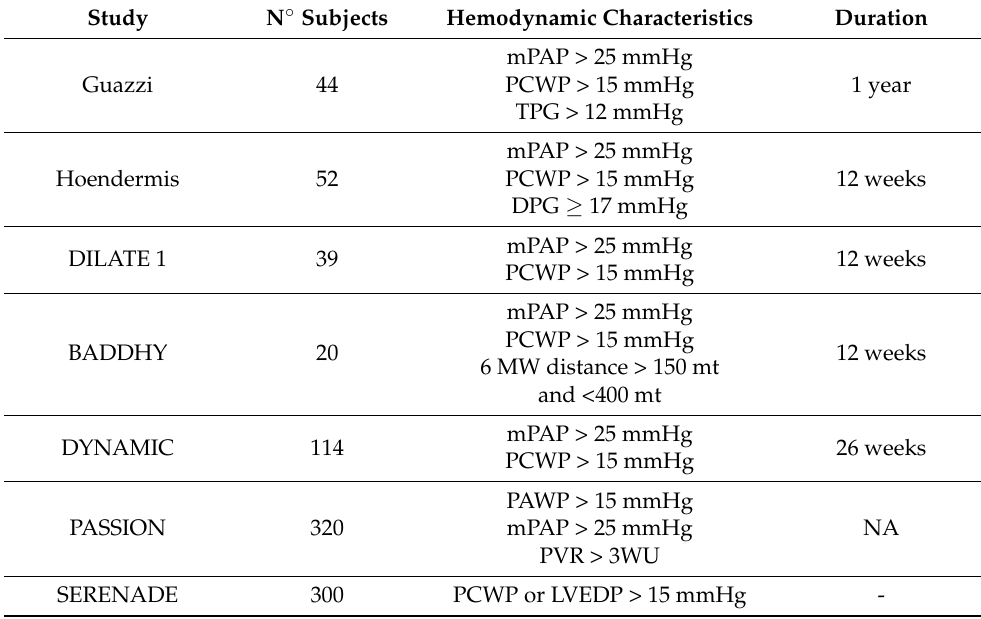
Table 2. List of HFpEF trials with hemodynamic evaluation and invasive heart catheterization. Study N ◦ Subjects Hemodynamic